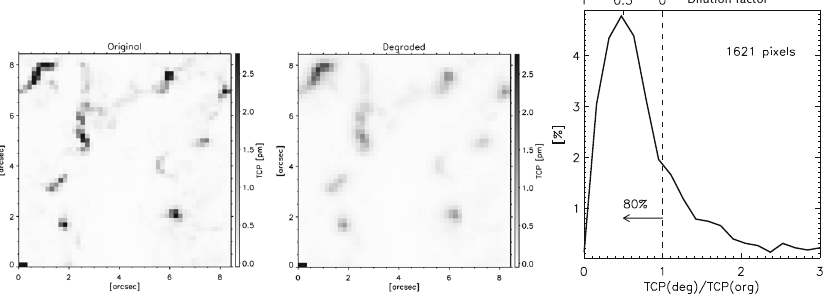
Fig.5 Maps of total circular polarization in Fe i 630.25 nm from a MHD model with mean field strength of 10 G before and after degradation by the Hinode PSF (left and middle panels). The panel on the right shows an histogram of the circular polarization ratio for pixels having degraded Stokes Q , U or V amplitudes larger than 4.5 times the noise level of 10 − 3 I QS . The rest of pixels cannot be inverted because their signals are too small. Image reproduced with permission from Orozco Suárez et al. (2007c), copyright by